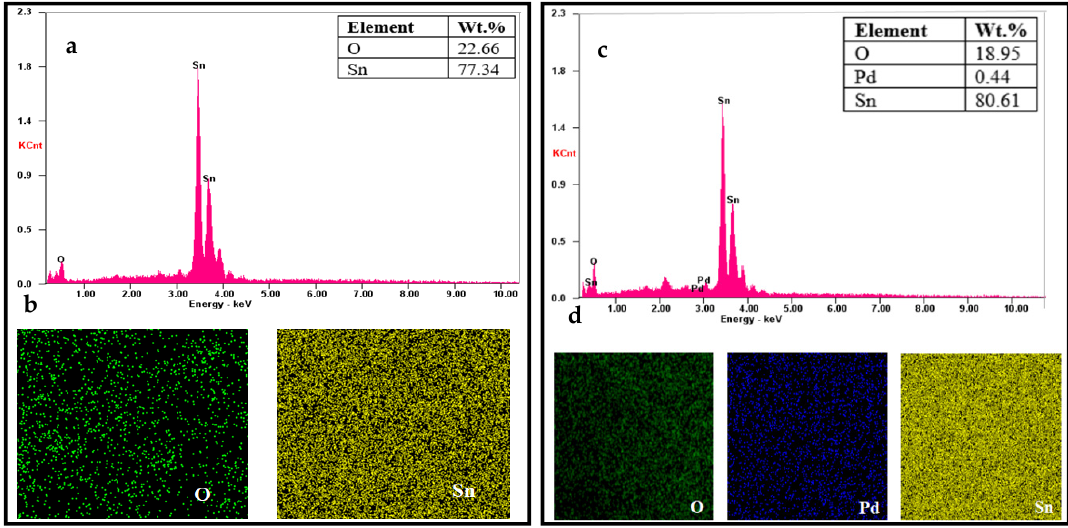
Figure 6. FESEM image showing the particle size of ( a ) SnO 2 , ( b ) SnO 2 with 0.1% Pd, ( c ) SnO 2 with 0.2% Pd, ( d ) SnO 2 with 0.3% Pd.